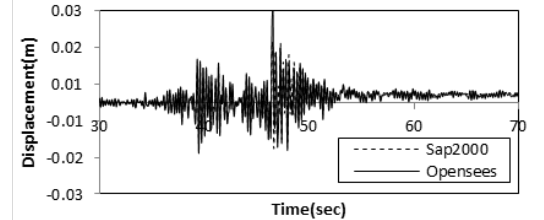
Fig. 8. Time history of top floor displacement of KO and KE frames (three story frames subjected to chichi ground